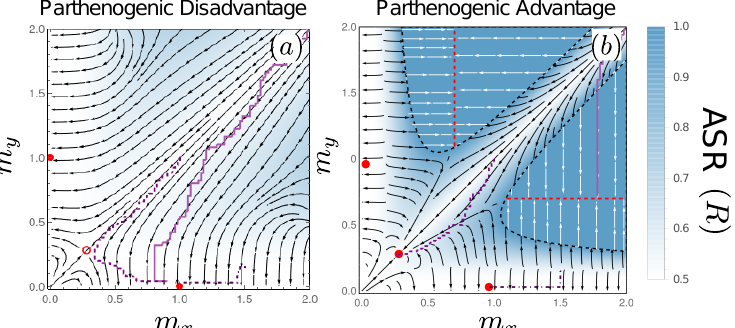
Figure A3. Evolutionary Dynamics under Mixed Sexual and Parthenogenic Reproduction over- laid with stochastic simulations of evolutionary trajectories (purple). Theoretical predictions in Panel ( a ) are the same as those in Figure 4a, with stochastic trajectories taken from Figure 2c. Theo- retical predictions in Panel ( b ) are the same as those in Figure 4b, with stochastic trajectories taken from Figure 2d. The three sets of initial conditions used for the stochastic simulations in both panels are: ( m x , m y ) = ( 2,2 ) (solid lines); ( m x , m y ) = ( 1,1 ) (dashed lines); ( m x , m y ) = ( 1.5,0.2 ) (dot-dashed